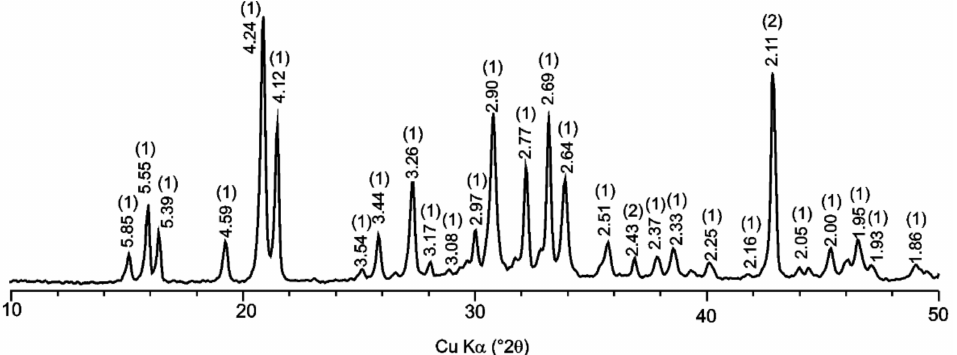
Figure 5. X-ray diffraction pattern of the magnesium potassium phosphate (MPP) matrix. 1— MgKPO 4 × 6H 2 O (K-struvite); 2—MgO (periclase).